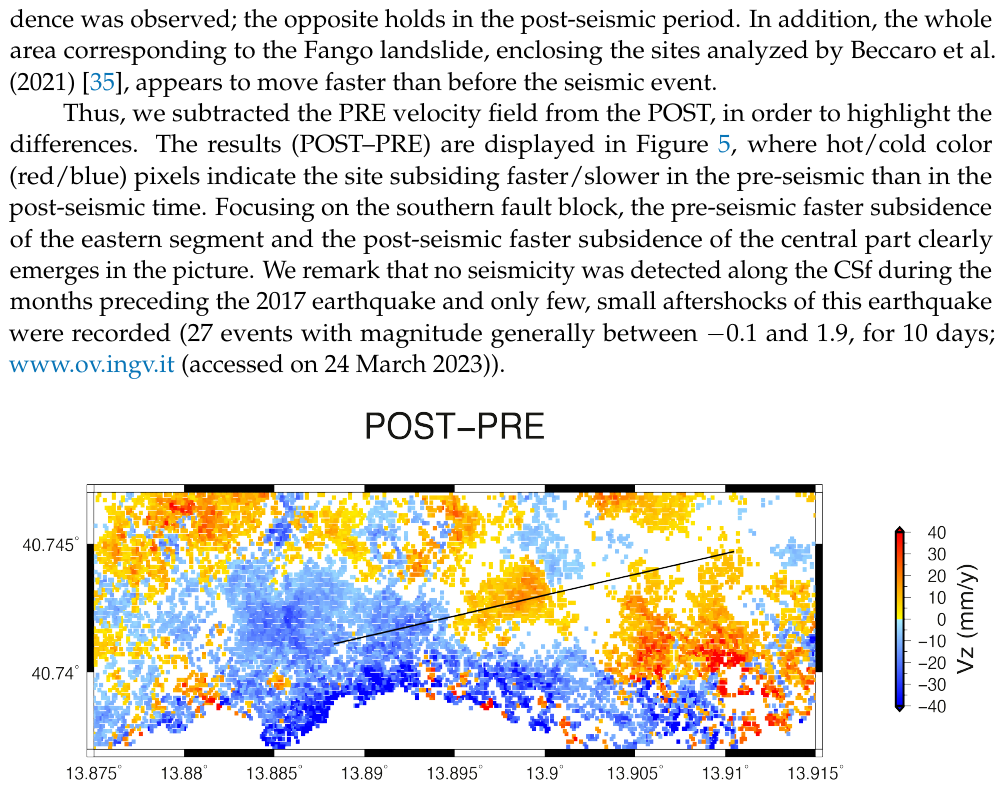
Figure 5. Difference of the velocity of the vertical ground motion in the period immediately follow- ing the earthquake (POST period; Figure 4c) minus the velocity measured in the period preceding the event (PRE period; Figure 4b). Only the points with velocity larger than the standard deviation σ are shown ( σ is reported in Supplementary Figure S5).